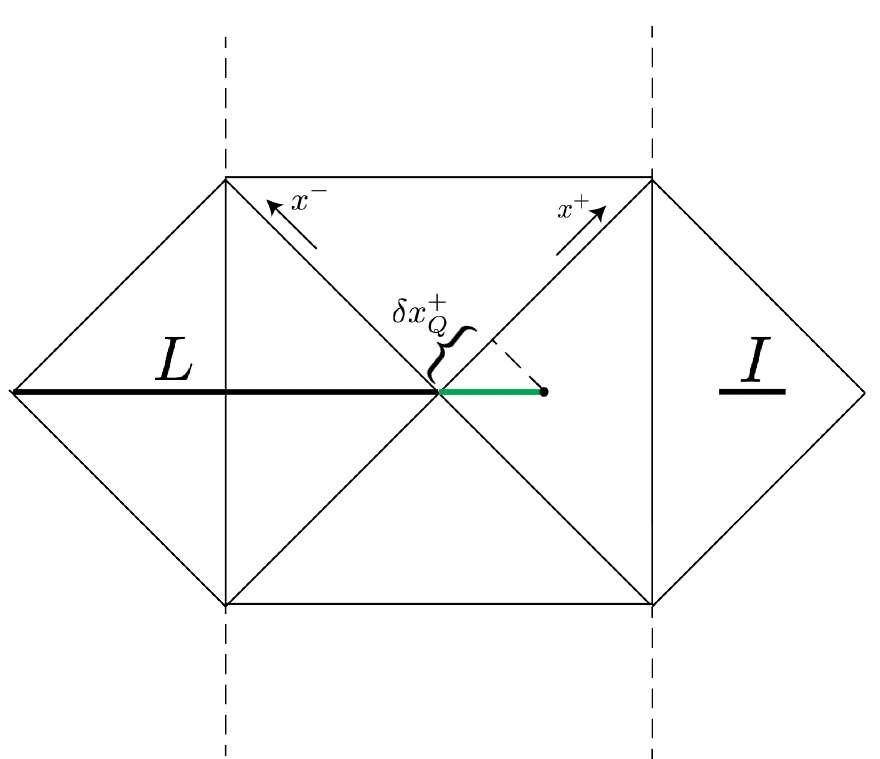
Figure 4 . Our setup in a model with JT gravity coupled to a 1+1 dimensional CFT, which is also coupled to an external